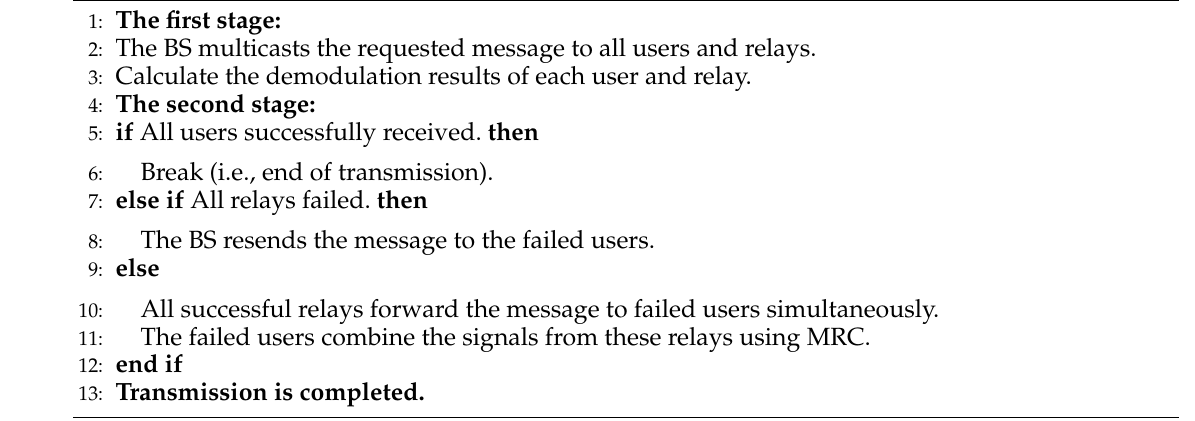
Algorithm 1 Two stages cooperative transmission